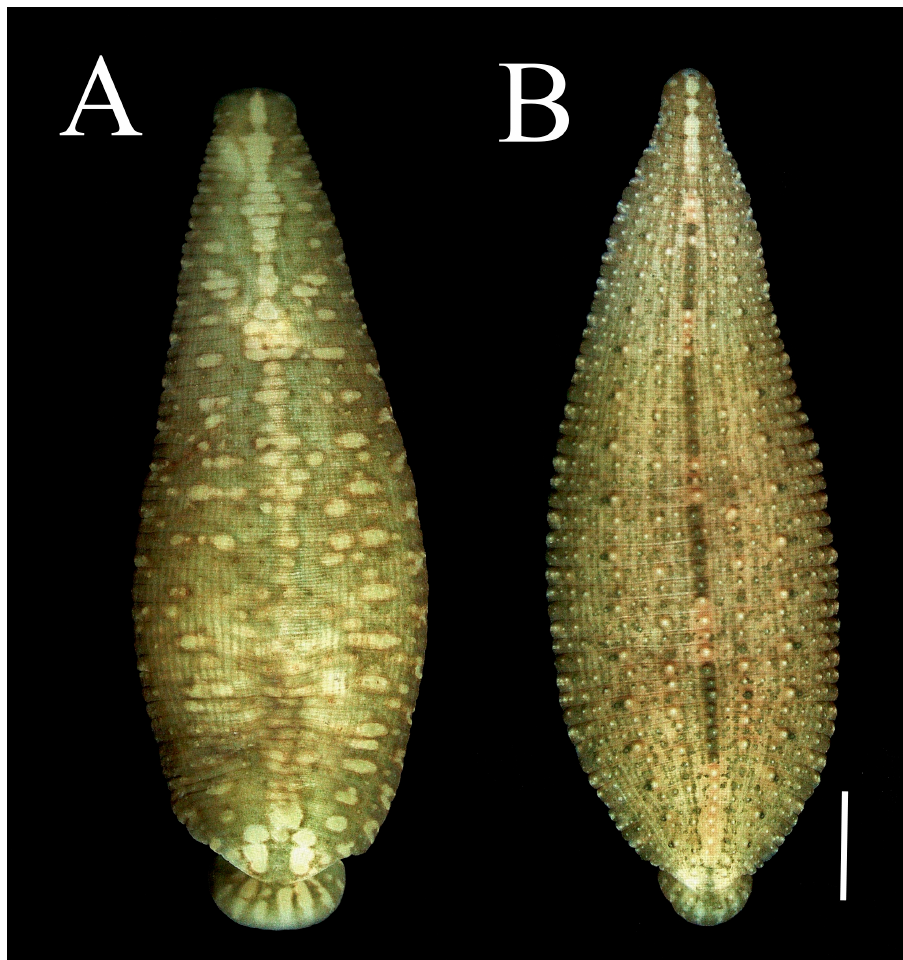
Figure 1. Smooth and tuberculated turtle leeches coexist on the same turtle assemblages in the Outer Banks, North Carolina. ( A ) Placobdella parasitica (PP ‐ 4a, 39.8 mm). ( B ) P. multilineata (PM ‐ 15a, 39.0 Outer Banks, North Carolina. ( A ) Placobdella parasitica (PP-4a, 39.8 mm). ( B ) P. multilineata (PM-15a, mm). Scale bar: 5.0 mm. 39.0 mm). Scale bar: 5.0